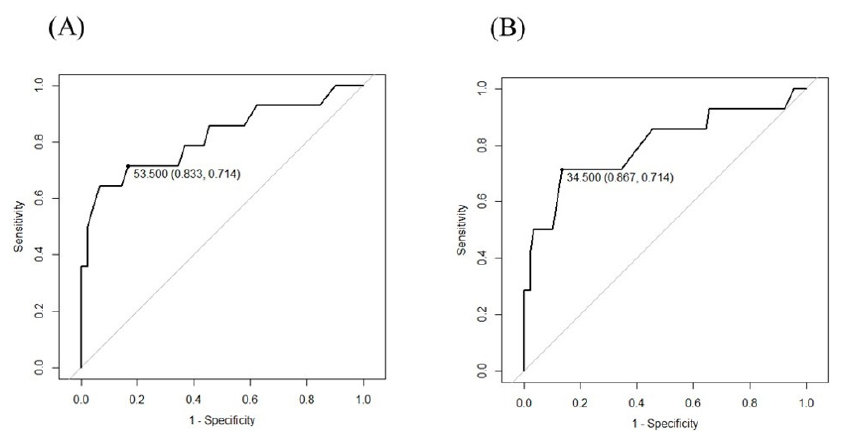
Figure 1. Receiver operating characteristic (ROC) analysis for the IAT ( A ) and the s-IAT ( B ). ROC: receiver operating characteristic; IA: internet addiction; IAT: Internet Addiction Test; s-IAT: the short version of the Internet Addiction Test.